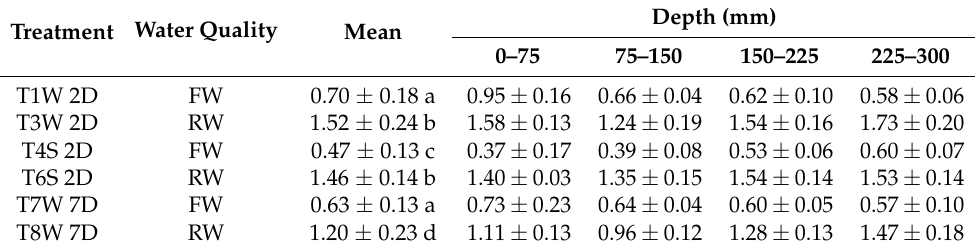
Table 5. Descriptive statistics of soil sodicity (SAR) between two water qualities, six irrigation meth- ods, and two irrigation scenarios (each value being a mean of three replicates ± standard deviation). Treatment Water